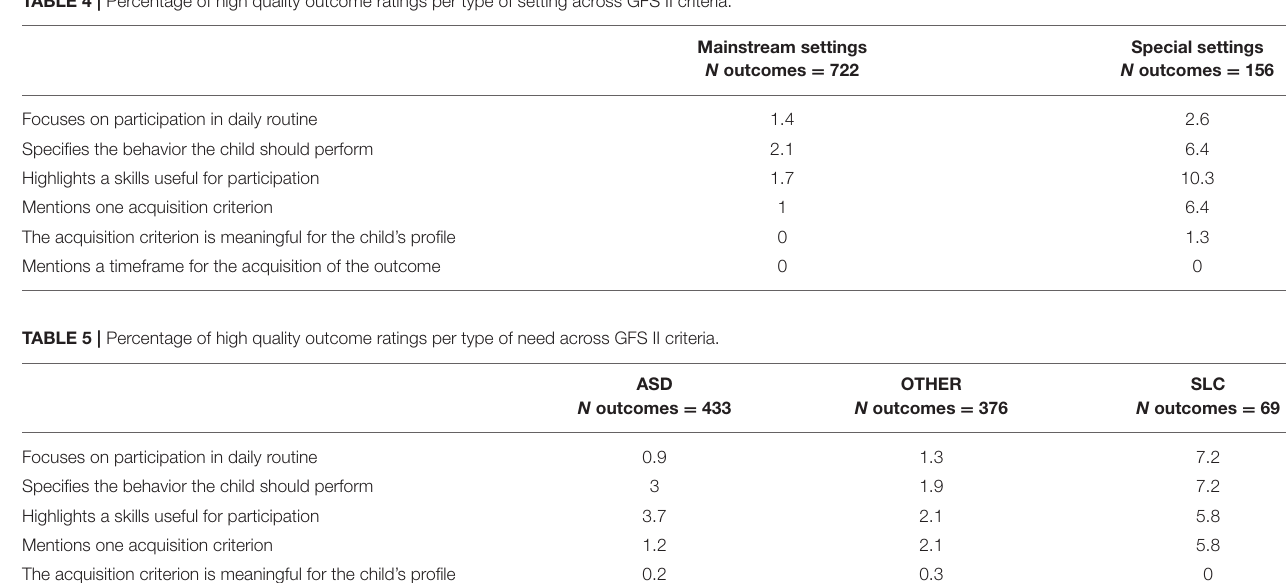
TABLE 4 | Percentage of high quality outcome ratings per type of setting across GFS II criteria.